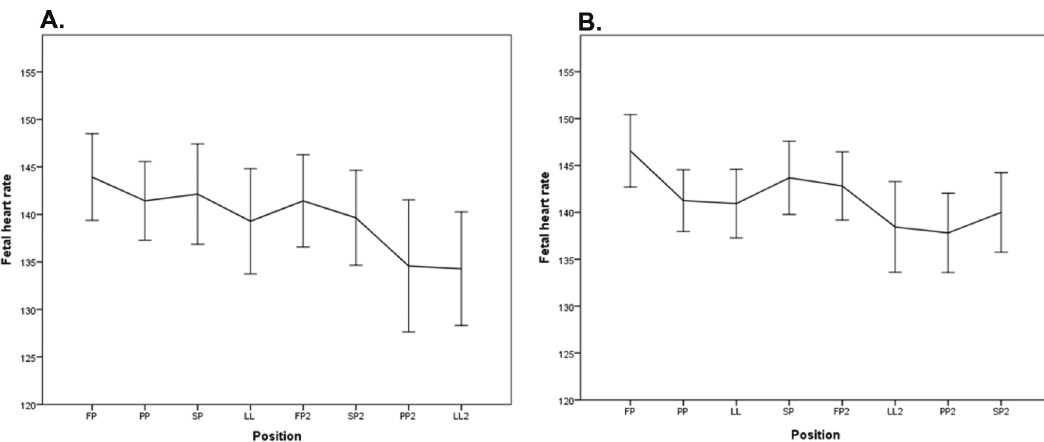
Figure 7 - Representation of the fetal heart rates of the fetuses of the pregnant women who performed sequence 1 (A) and sequence 2